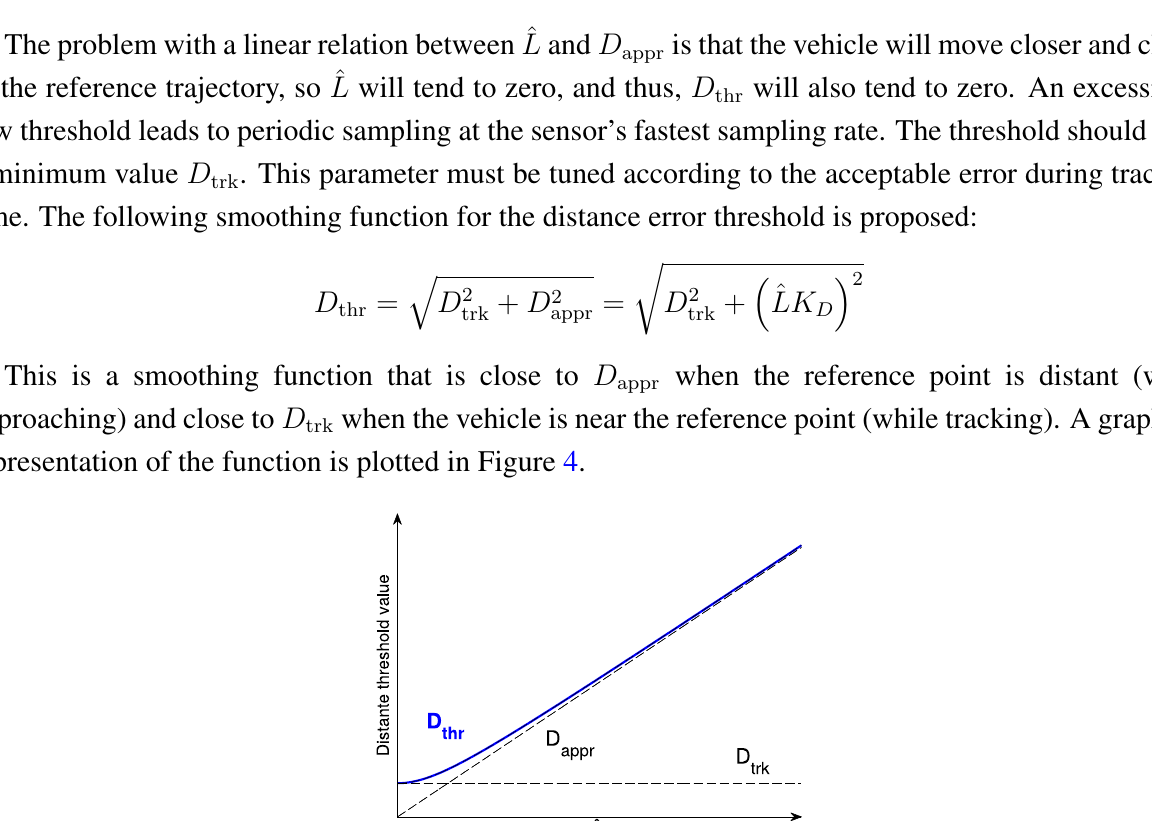
as a function of the distance to the thr